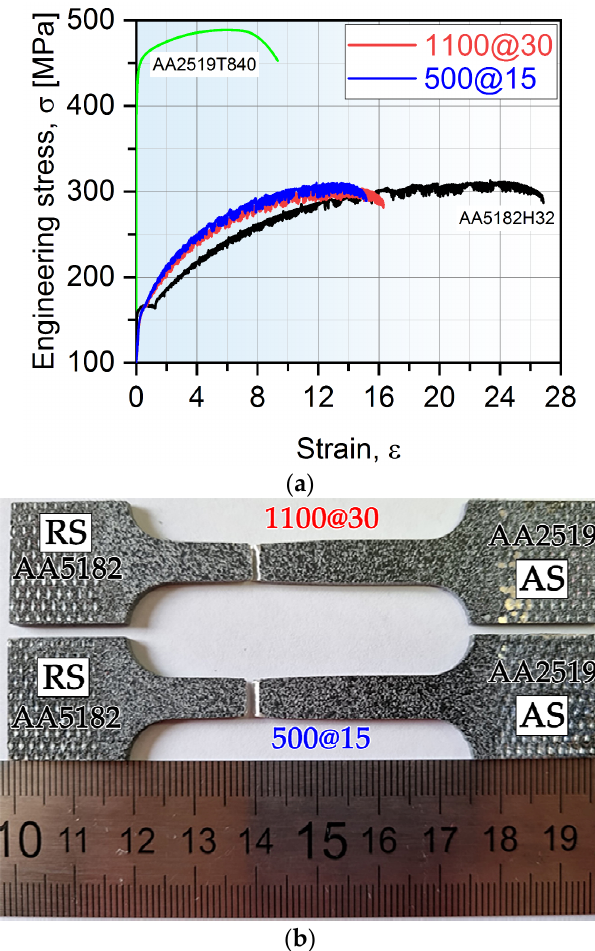
Figure 5. Typical engineering stress–strain curves ( a ) for base materials and dissimilar welding joints; ( b ) the typical appearance of the fractured tensile test specimens. Table 3. Tensile properties of base materials and dissimilar welds.